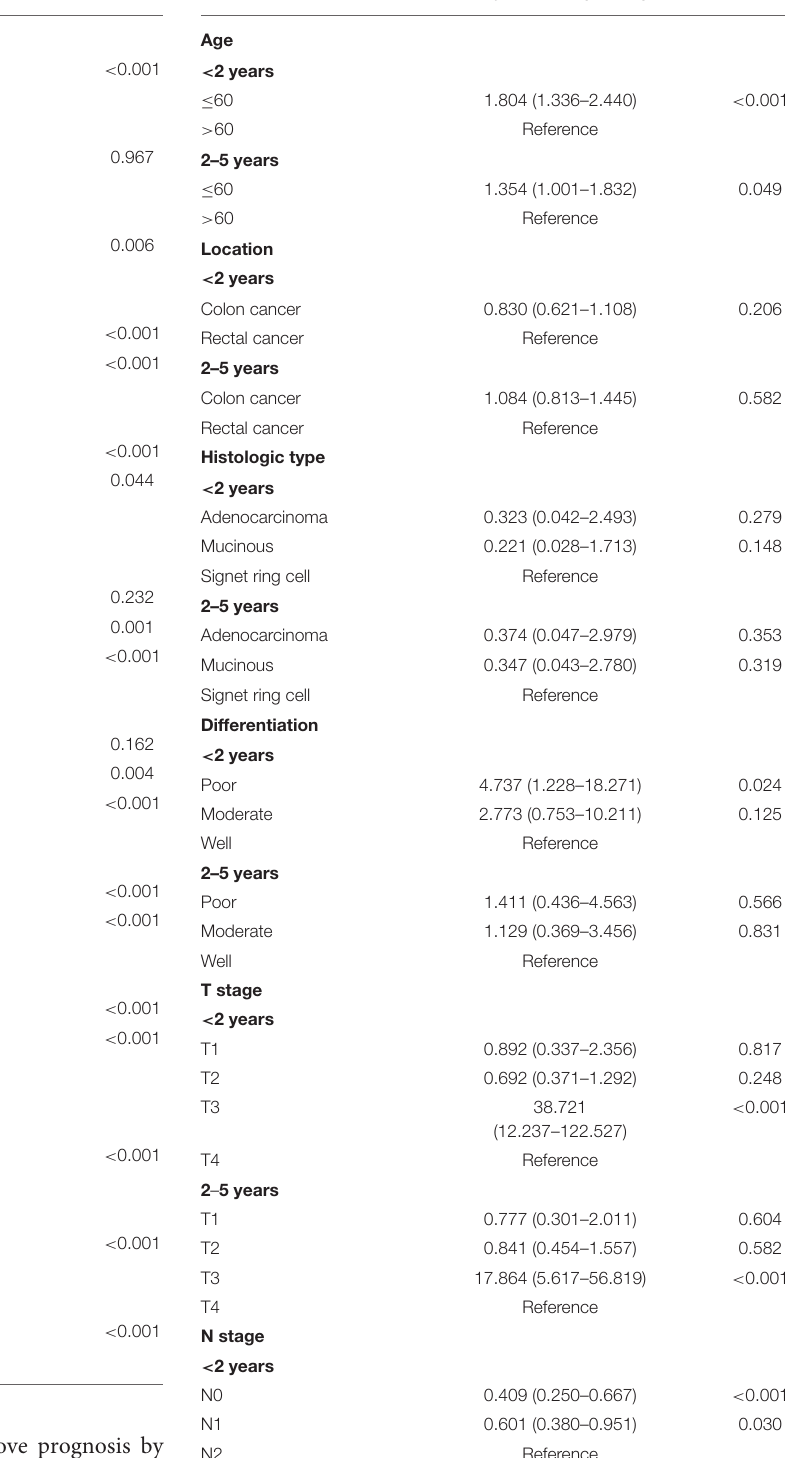
TABLE 2 | Univariate ordinal logistic regression or multinomial logistic regression analysis of the factors associated with recurrences < 2 years, 2–5 years, and > 5 years after radical surgery ( < 2 years as a reference).